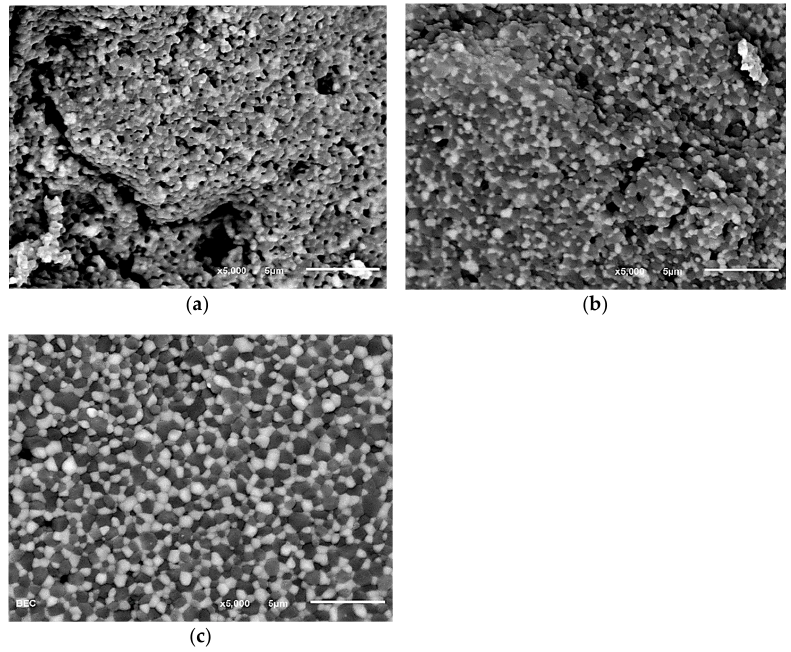
Figure 5. Typical back scattered electron images of reticulated porous ZTA specimens prepared using coarse zirconia when sintered at ( a ) 1400 °C ( b ) 1500 °C ( c ) 1600 °C. Typical backscattered electron images of the reticulated porous ZTA specimens when sintered at 1400, 1500, and 1600 °C, prepared from coarse zirconia particles, are shown in Figure 5a–c, respectively. The lighter color denotes the zirconia particles. It can be confirmed that the average particle size of alumina and zirconia increased as the sintering temperature was increased. When the reticulated porous ZTA was sintered at 1400 °C, there were many open pores between the alumina and zirconia particles, and densification was not achieved owing to the presence of many pores. Open pores between the particles and densification affect the compressive strength. The process of sintering can be explained by dividing it into the initial stage, intermediate stage, and final stage. In the initial stage of sintering, the interface of the particles to each other adheres to form a neck. In the intermediate stage of sintering, the pores gradually become round and grain growth occurs, resulting in larger particles than the raw material powder. After that, at the final stage of sintering, the pores become spherical and close, resulting in closed pores and additional grain growth. In addition, the higher the sintering temperature, the faster the sintering reaction occurs [27]. The microstructures when the reticulated porous ZTA is sintered at 1400, 1500, and 1600°C correspond to the initial stage, intermediate stage, and final stage of the sintering process, respectively. Figure 4a shows that the compressive strength of the reticulated porous ZTA specimens was lowest when sintering was conducted at 1400 °C. When the reticulated porous ZTA specimens were sintered at 1500 °C, the number of open pores decreased and the grain boundaries between the alumina and zirconia particles became connected. When the reticulated porous ZTA specimens were sintered at 1600 °C, the grain size grew because there were no pores interfering with the grain growth process. These specimens showed the highest compressive strength due to the highest densification between the alumina and zirconia particles. Therefore, we set the sintering temperature to 1600 °C. 3.1.4. The Effect of the Average Particle Size of ZTA on the Reticulated Porous ZTA Specimen Generally, there is a limited range of average particle sizes that can be controlled with several methods, such as ball-milling. It is well known that the effect of ball-milling is marginally effective when the average particle size range approaches the nano-scale [22]. Therefore, the average particle size was controlled by ball-milling coarse zirconia particles in the micro-size range. Figure 6a shows the particle size distributions with various average particle sizes, which were controlled by adjusting the ball-milling time. The average particle size is a process parameter used to obtain the optimal composition. As the ball-milling time was increased, the average particle size decreased to 0.267 µm, 0.181 µm, 0.152 µm, and finally to 0.100 µm.